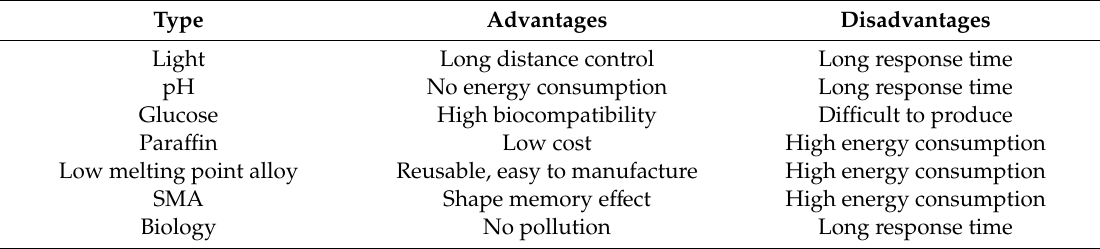
Table 9. Comparison of different microvalves based on properties of material and creature. Type Advantages